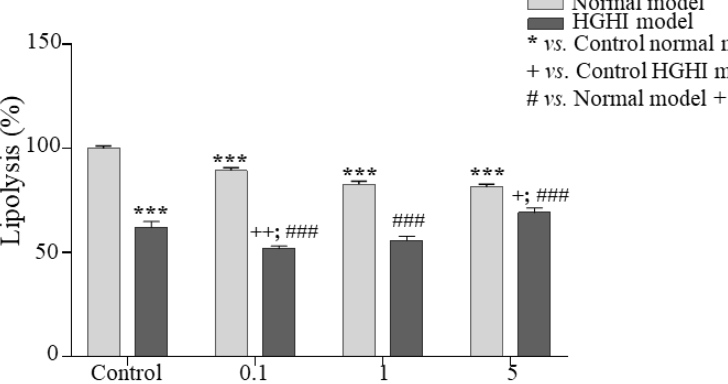
Figure 4. Lipolysis of the adipocyte. Free glycerol of the carvone chemotype L. alba EO. *** p < 0.001 vs. control (not treated with EO) of the HGHI model; *** p < 0.001 with respect to control model without EO; + p < 0.05; and ++ p < 0.01 with respect to the pathological model without EO treatment; ### p < 0.001 with respect to control model treated with